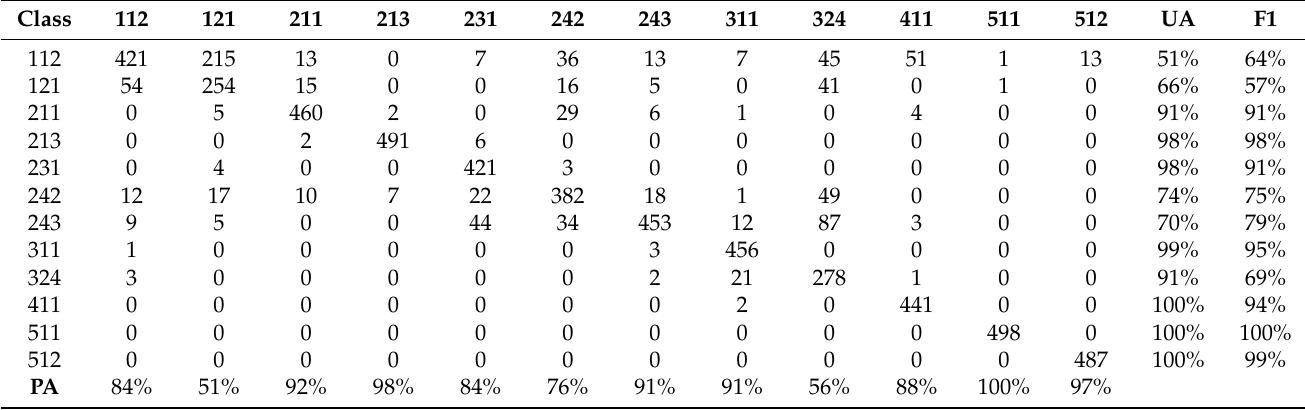
Figure 14. North Braila map based on Support Vector Machine, Radial Basis Function kernel classifier, Sentinel-2 images, Overall accuracy: 84%, and Kappa coefficient 0.82. Table 5. Confusion matrix of the North Braila area (SVM RBF, Sentinel-2 images, overall accuracy (OA): 84%, Kappa coefficient 0.82, UA—User Accuracy, PA—Producer Accuracy,